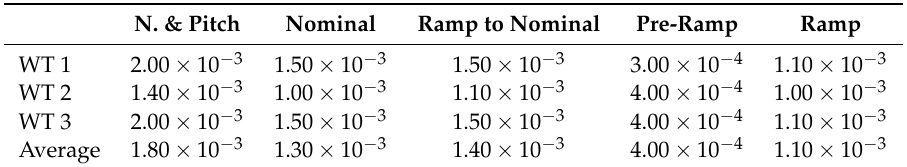
Table 4. Steadiness of the different OR by